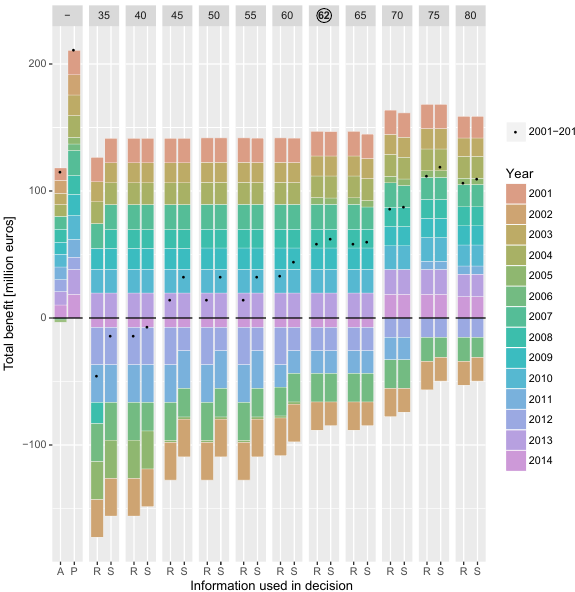
Figure 6. Total benefit for decisions informed by reservoir level alone (R) and with the addition of snow information (S) for the 10 sets of thresholds and the optimized thresholds (labelled as 62). The total benefit for uninformed decisions (A) and perfect information (P) is included as a reference. The colours indicate the yearly benefit while the points represent the total benefit for the period (total gains – total